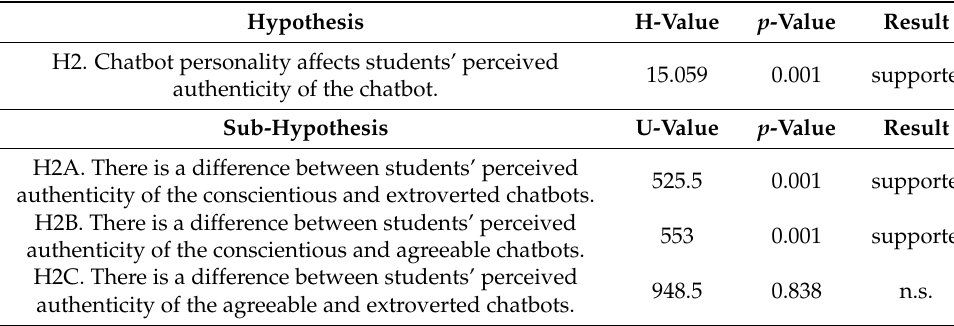
Table 4. Hypothesis 2 Testing